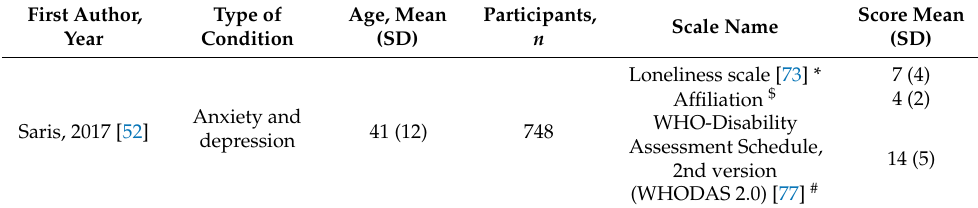
Table 9. Socio-affective functioning II.